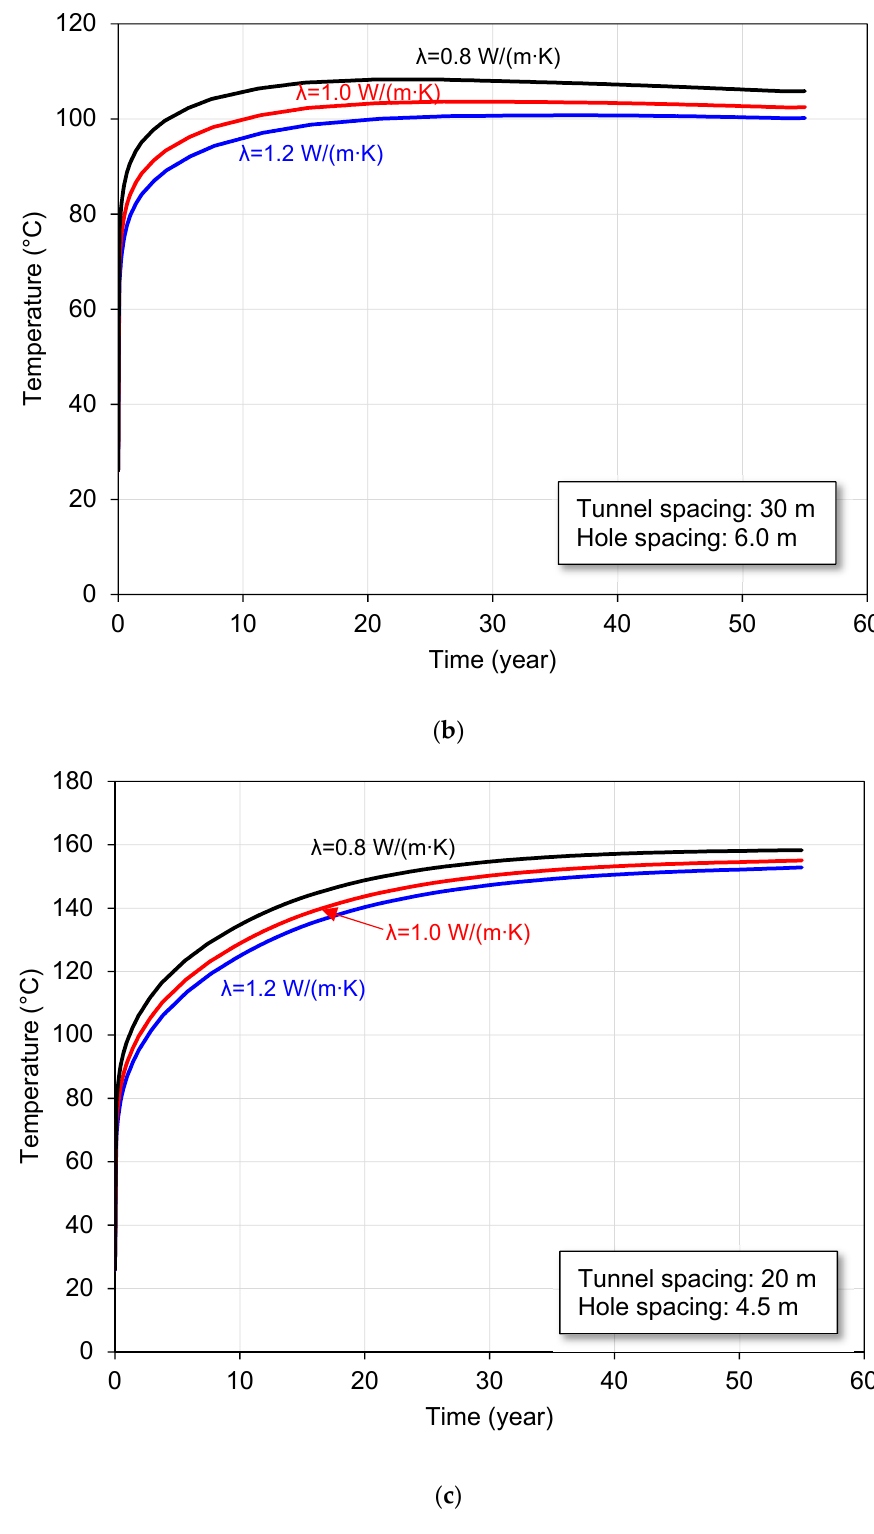
Figure 7. Temperature of buffer surface facing the canister with time according to the tunnel and hole spacing and thermal conductivity of the buffer: ( a ) tunnel and hole spacing are 40 and 7.5 m, respectively, ( b ) tunnel and hole spacing are 30 and 6.0 m, respectively, ( c ) tunnel and hole spacing are 20 and 4.5 m, respectively.